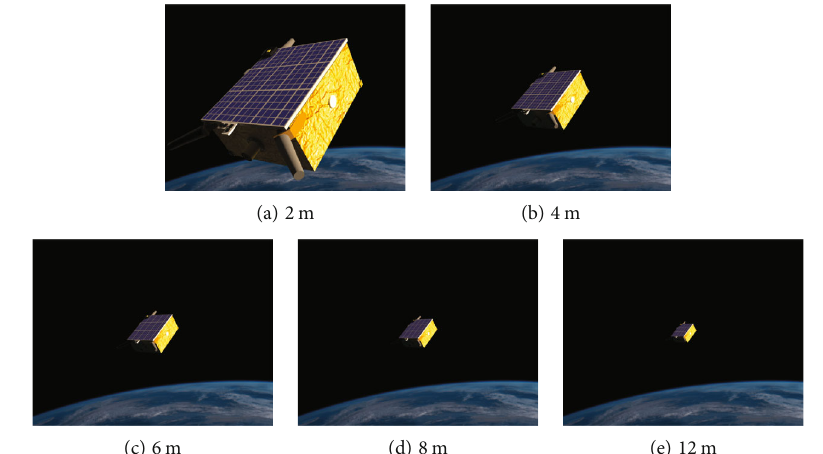
Figure 12: Visible images of di ff erent imaging range.